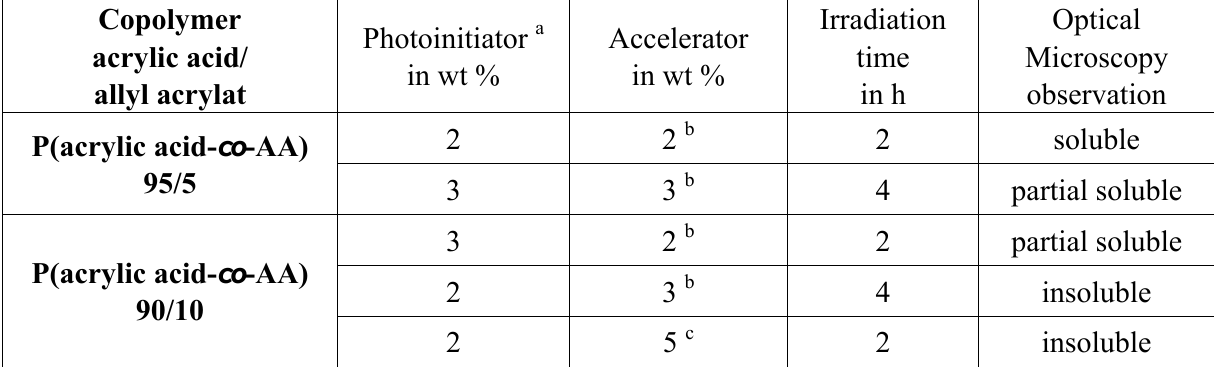
Table 1. Water solubility of the coating: Effect of the ratio of repeating units, the photoinitiator, the accelerator and the irradiation